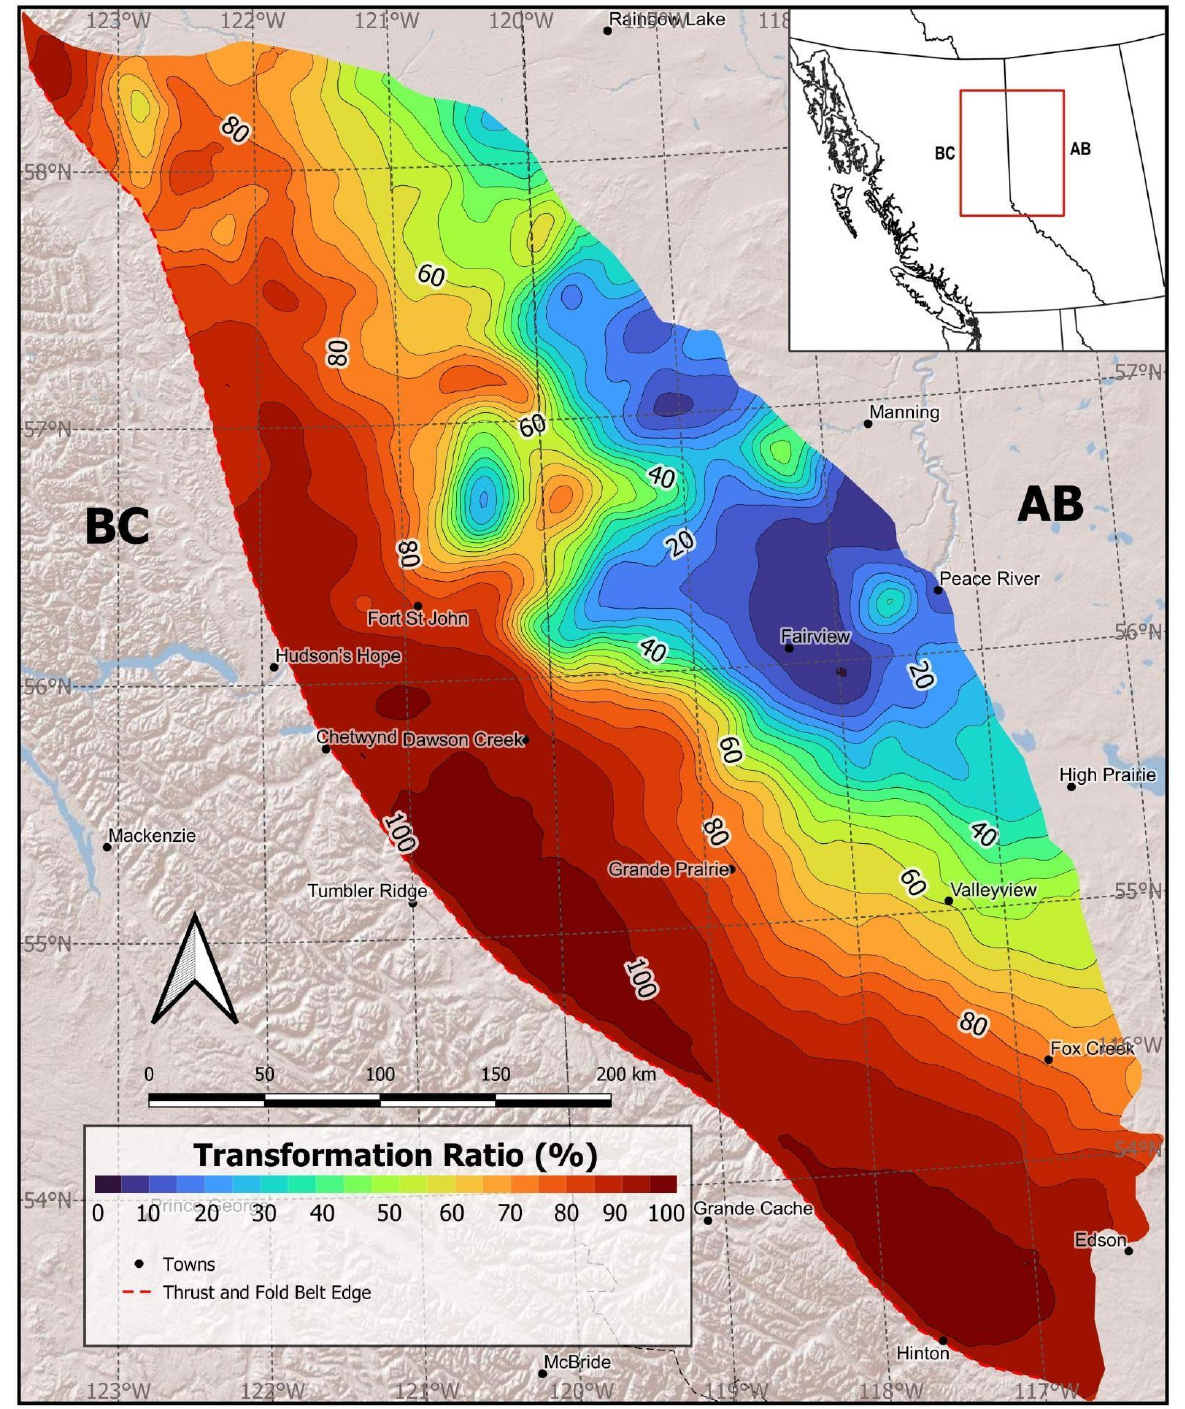
Figure 23. Present day kerogen transformation ratio in the Middle Montney Formation. The subsidence continued until approximately 50 Ma, and the Montney Formation in the southwest reached the late dry gas window (transformation ratio at 100%) before thermal maturation arrested by the rapid uplift and exhumation of Paleogene sediments.